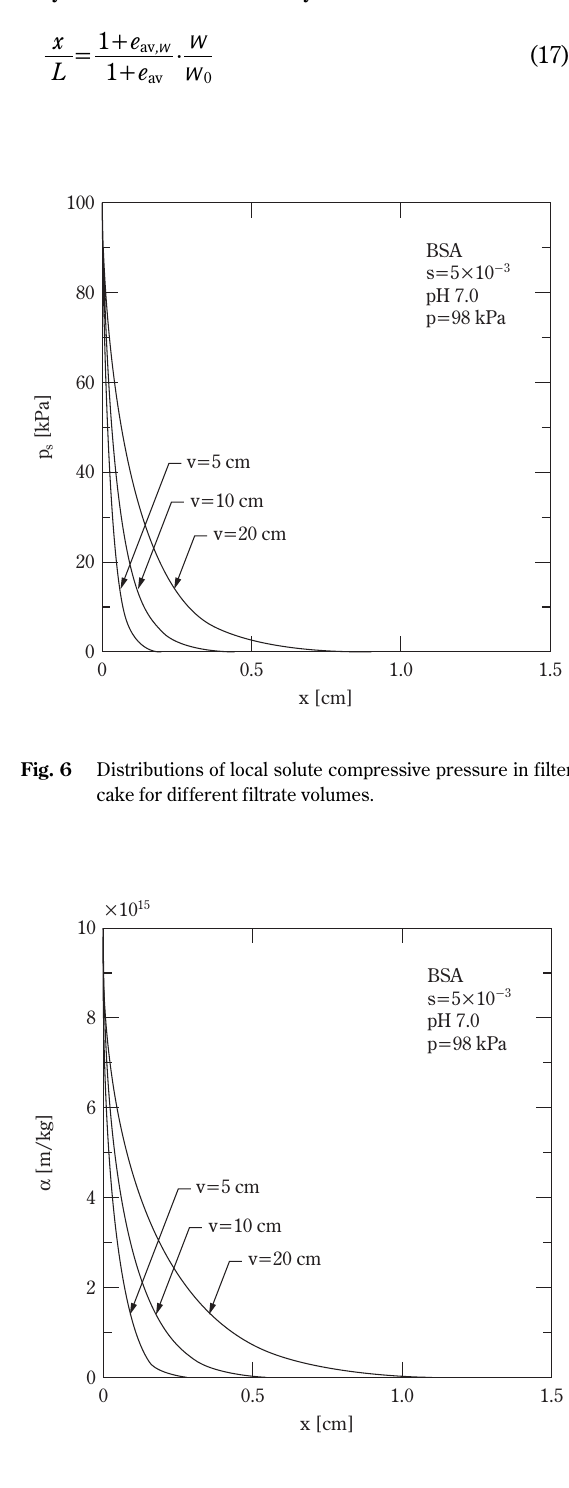
Fig. 5 Effect of applied filtration pressure on average specific fil- tration resistance and average void ratio of filter cake for different values of pH.